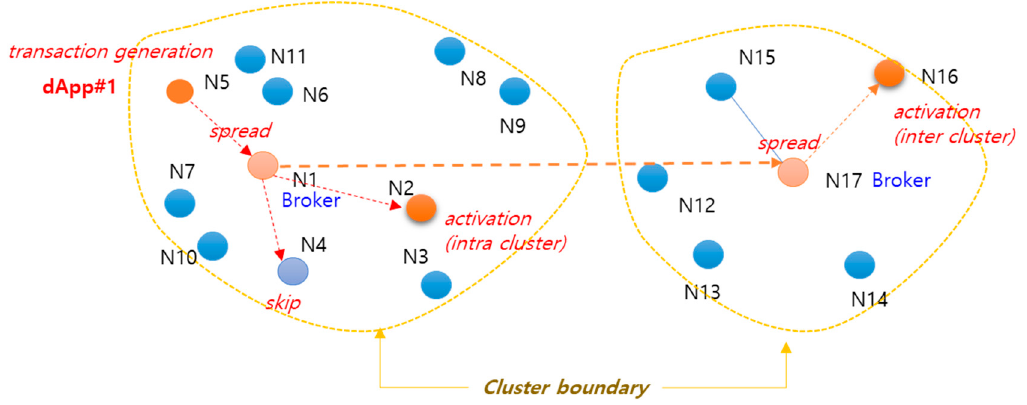
Figure 4. Regional dApp spreading and execution.